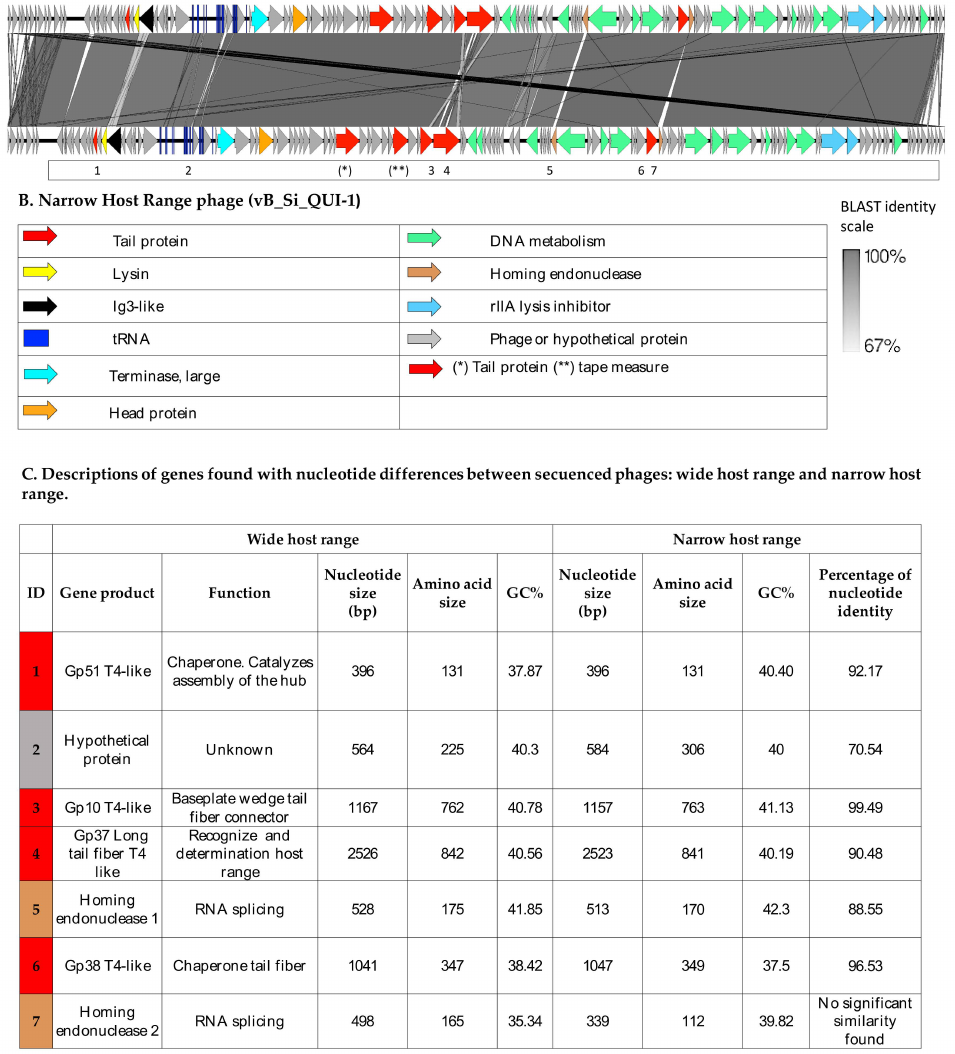
Figure 2. Linear representation of the genomes of wide- and narrow-host-range phages. EasyFig software version mc 2.1 [48] was used to construct a comparison using the BLAST algorithm of WHR and NHR phages. ( A ) Wide-host-range phage and ( B ) narrow-host-range phage. The presence of similar genes is shown in the figure. The genes were labeled with di ff erent colors according to functionality: tail proteins, lysin, Ig3-like, tRNA, terminase large, head protein, DNA metabolism, homing endonuclease, rlla lysis inhibitor. BLAST identity is represented in gray-scale, with dark gray indicating a greater BLAST identity and light gray representing a lesser BLAST identity. Numbers indicate genes with di ff erences described in C; ( C ) description of genes found with di ff erences in the shared nucleotide identity between both